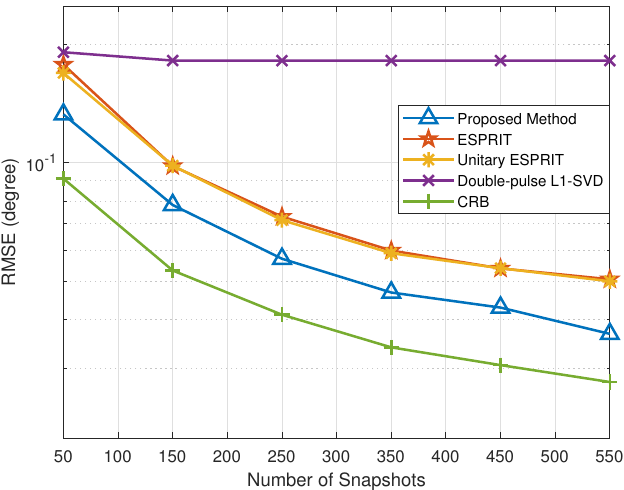
Figure 5. RMSE of DOA estimation versus snapshots.